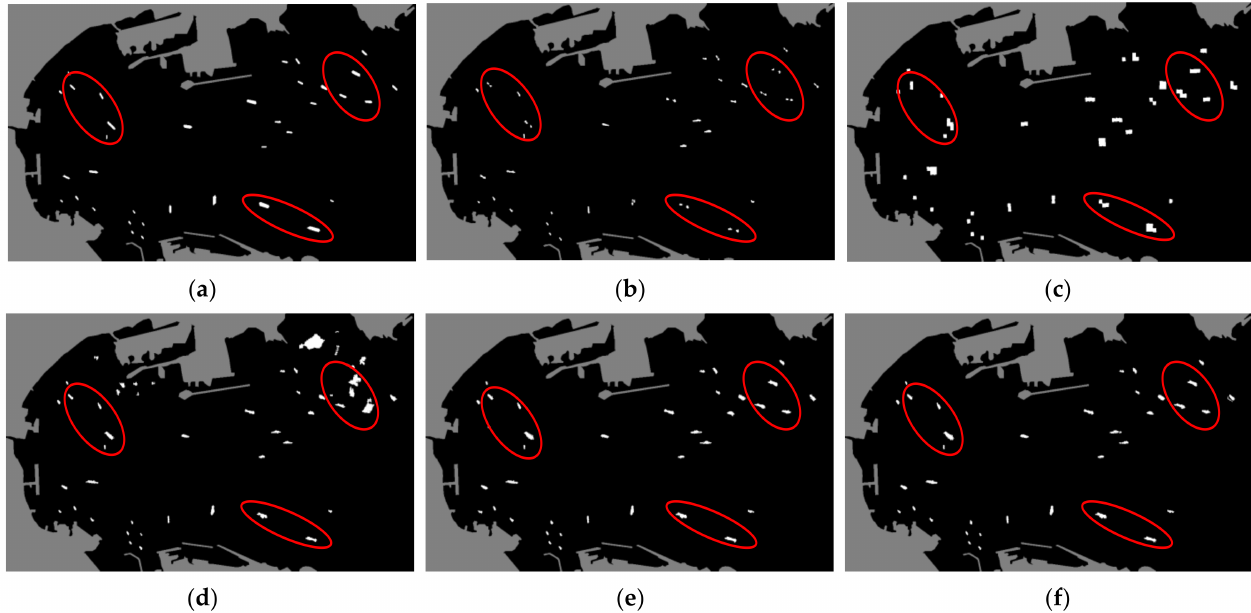
Figure 12. Detection results from Radarsat-2 area II. ( a ) The ground-truth images. ( b ) SO-CFAR. ( c ) SP. ( d ) T3 + SVM. ( e ) PCP + SVM. ( f ) Proposed